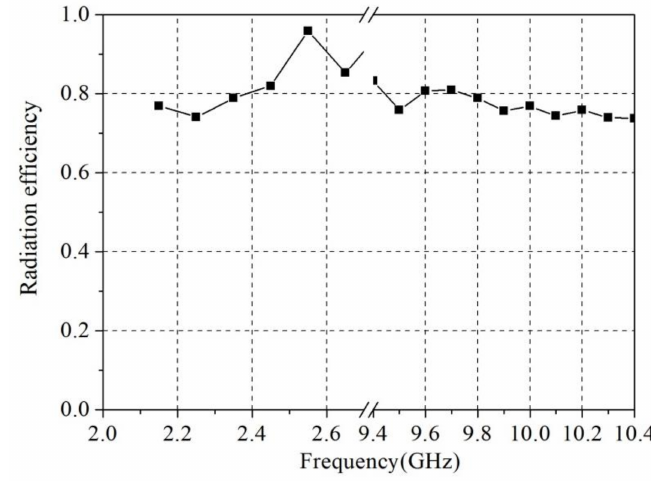
Figure 12. Radiation efficiency of the proposed antenna.